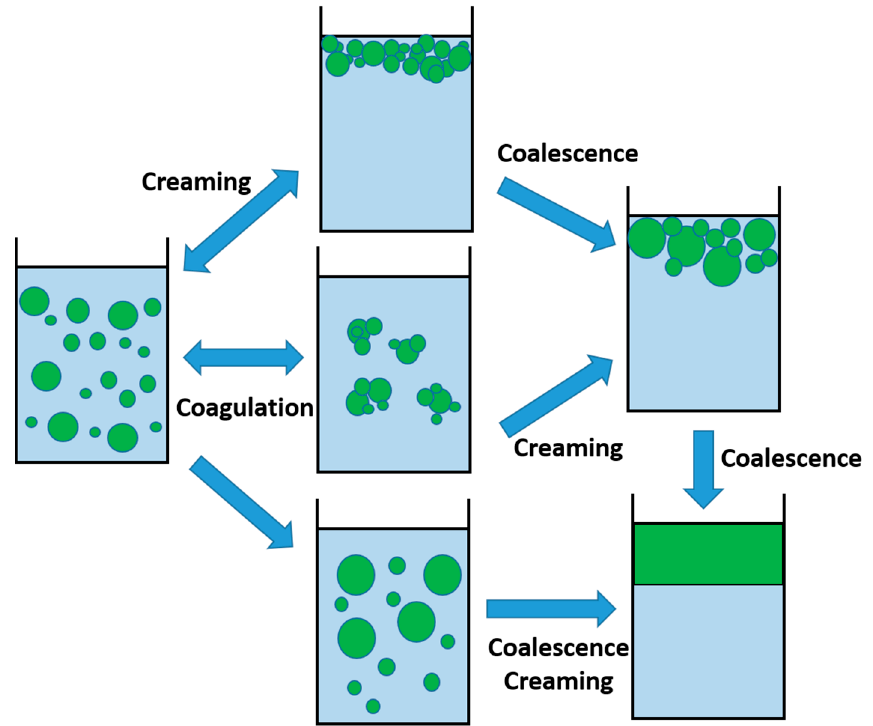
Figure 2. Schematic sketch of emulsion instabilities. Evolution between creaming, coagulation, coalescence.